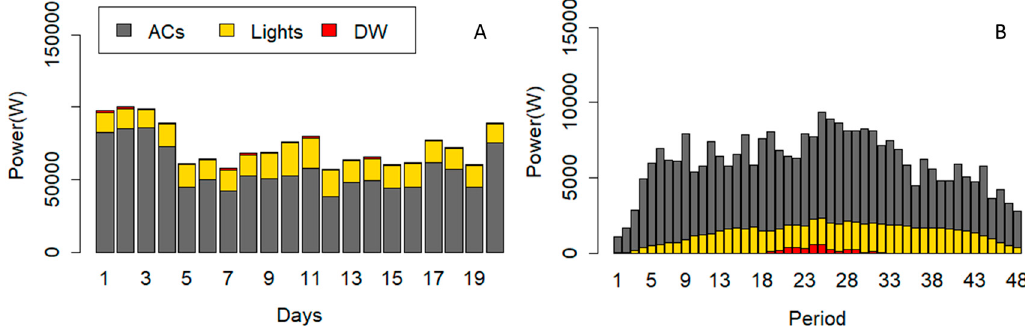
Figure 12. Power consumption of the devices after optimization in scenario B. ( A ) is correlated to power consumption of devices in each day, and ( B ) shows the average power consumption of devices in each period.